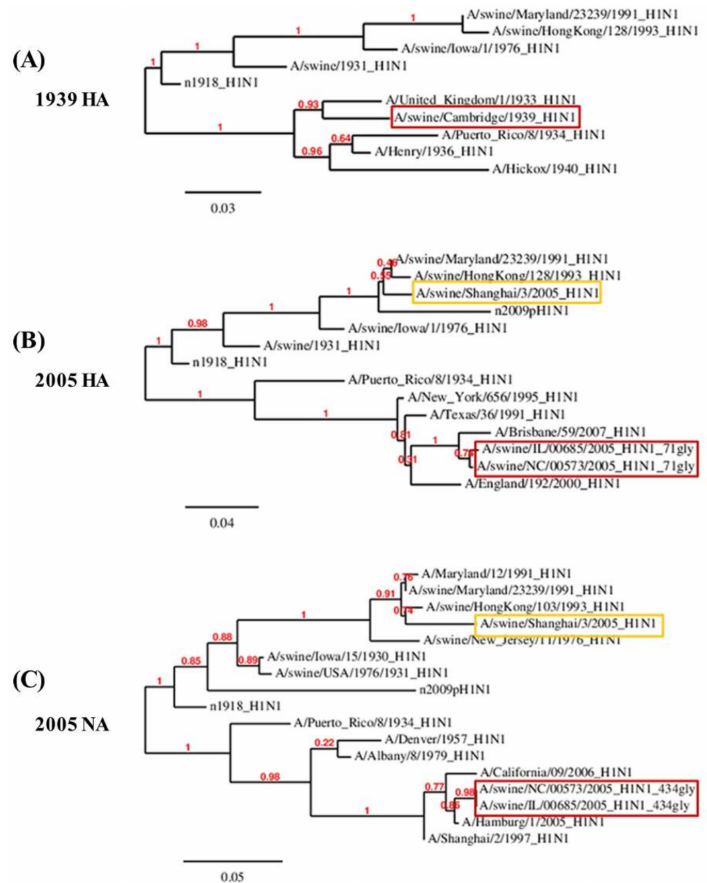
Figure 6. Phylogenetic tree of specific swine isolates that have incorporated human glycosylation patterns. A phylogenetic tree was used for analyzing the sequence correlation of swine isolates carrying glycosylation patterns of human isolates (rectangular red) among other classical swine and human seasonal flu isolates. The 1939 swine HA was very similar to a 1933 human influenza HA isolate ( A ). The 71 glycosylated HA in ( B ) and 434 glycosylated NA in ( C ) from 2005 swine isolates matched human isolates; however, the non-glycosylated 2005 swine isolates at HA 71 and NA 434 (rectangular yellow) had low similarities with human